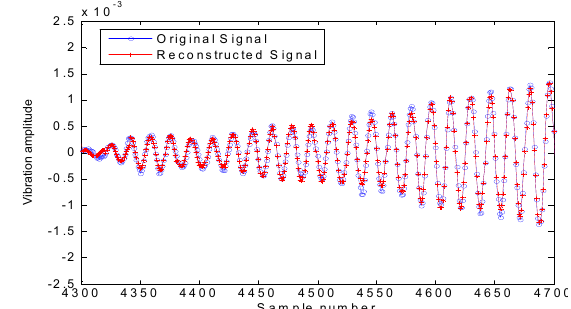
Fig.2 Comparison between the orignal and reconstructed